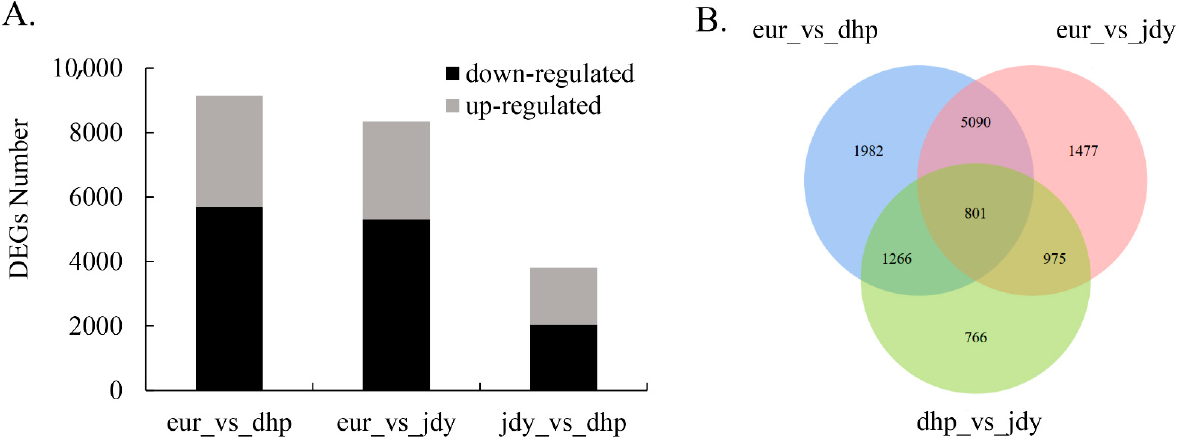
Figure 4. DEGs among 3 chestnut cultivars. A. The number of up- and downregulated DEGs (|log 2 fold change| ≥ 1 and FDR< 0.05). B. Venn diagrams of DEGs among the three sampling groups (|log 2 fold change| ≥ 1 and FDR < 0.05).